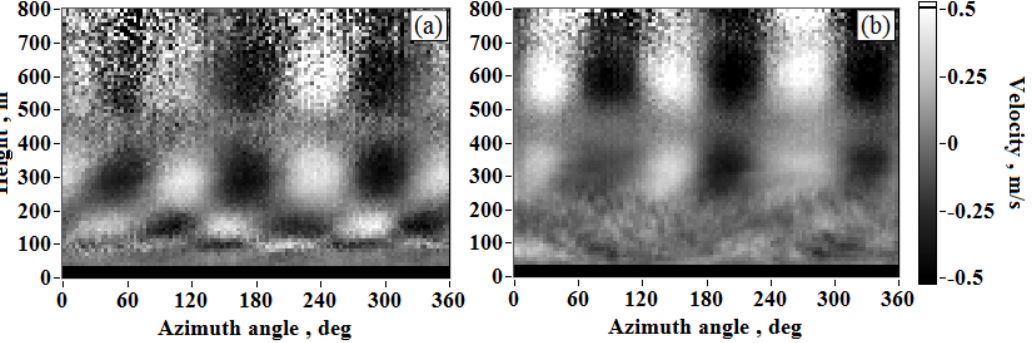
Figure 3. Distributions of estimates of radial velocity fluctuations V (cid:48)(cid:48) measurements by the StreamLine lidar at 23:00 ( a ), 23:01 ( b ), 23:02 ( c ), and 23:03 ( d ) on 22 July 2016 with the use of Equation (9).